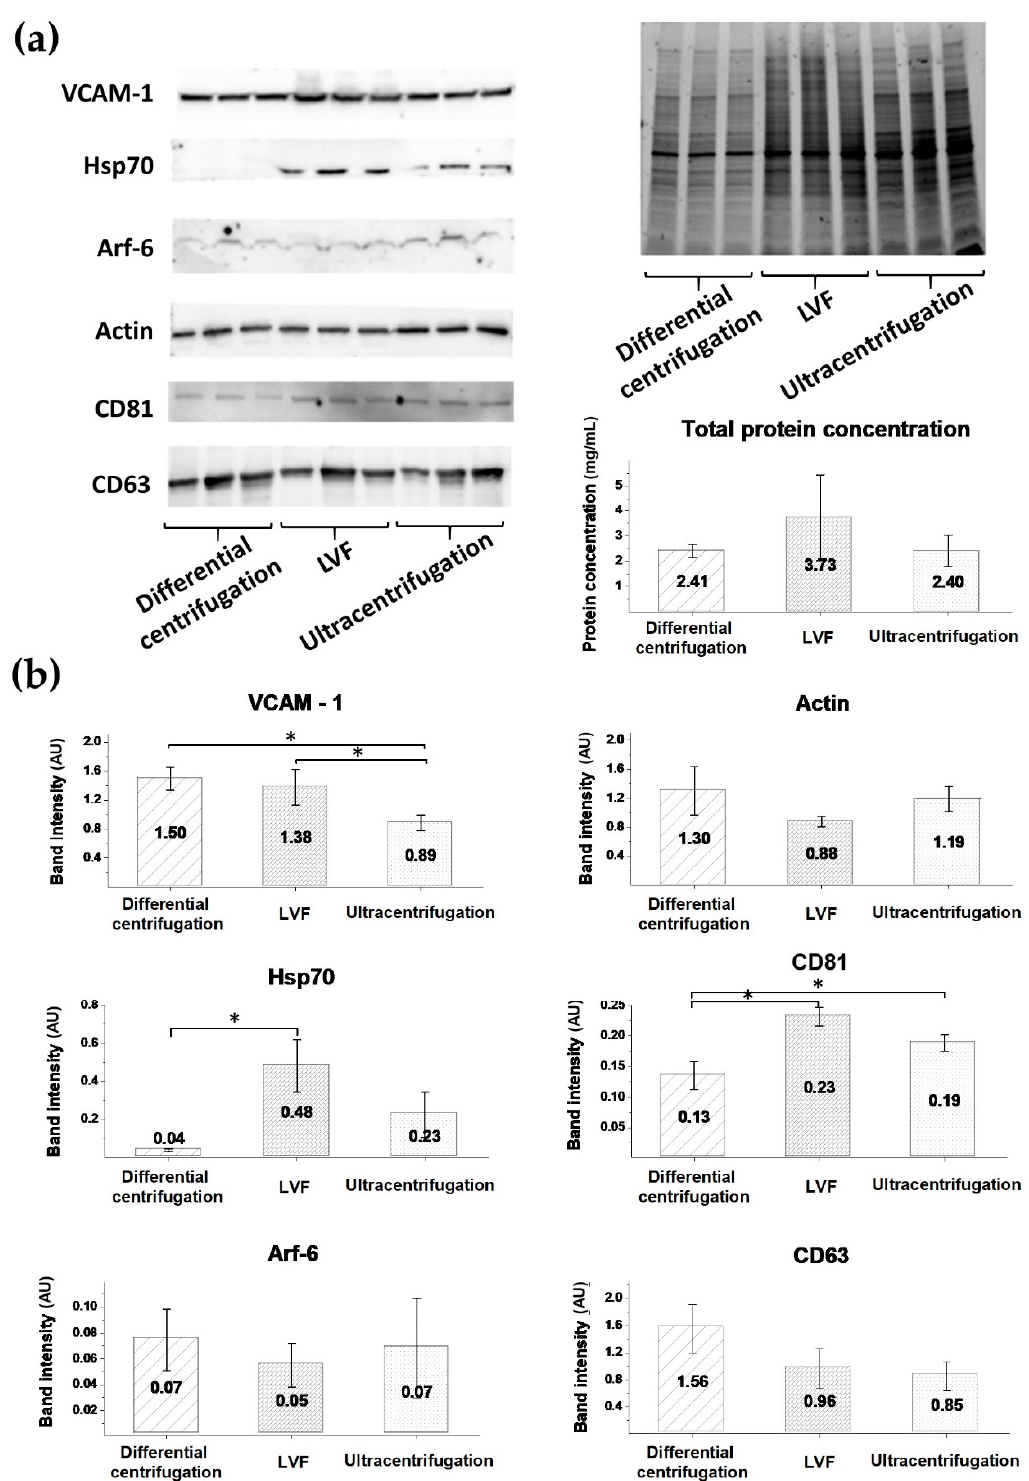
Figure 7. Results of the Western blot analysis. ( a ) Images of the membrane after blotting and the gel after electrophoresis with clearly visible differences in bands’ intensities between the EV samples isolated by different methods; ( b ) Band intensity analysis. Data are presented as mean values (column) and SDs (whiskers). The analysis was performed using the Kruskal–Wallis test. Differences between subgroups were tested with Dunn’s posthoc test, and statistically significant differences are marked with an asterisk ( p < 0.05).